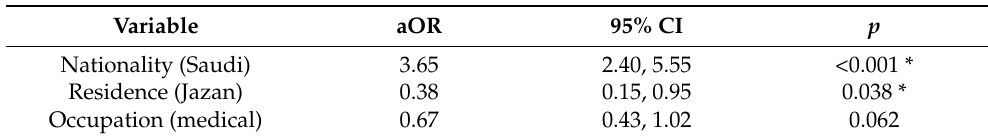
Table 5. Multivariate analysis of factors associated with reporting of side-effects following COVID-19 vaccine among the participants ( n =